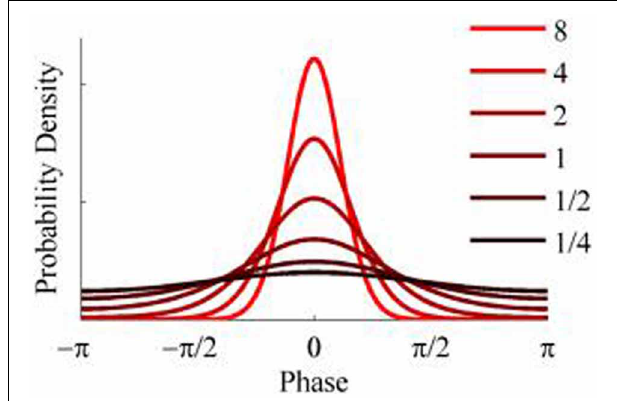
FIGURE 2 | Probability density functions of the von Mises distribution for different values of concentration, κ